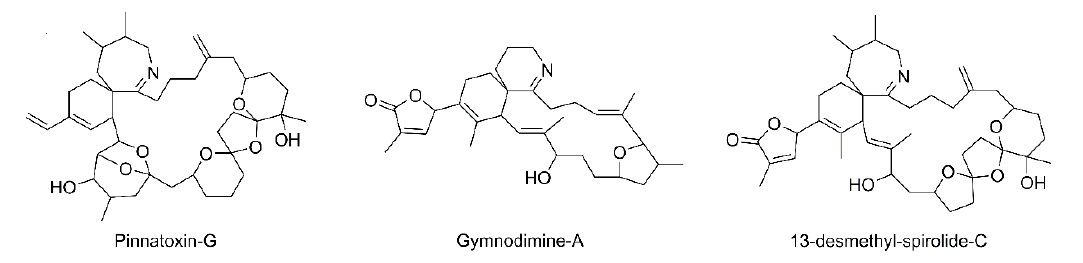
Figure 1. Structures of representative cyclic imines with commercially available standard solutions used for liquid chromatography-tandem mass spectrometry (LC-MS/MS) analysis.